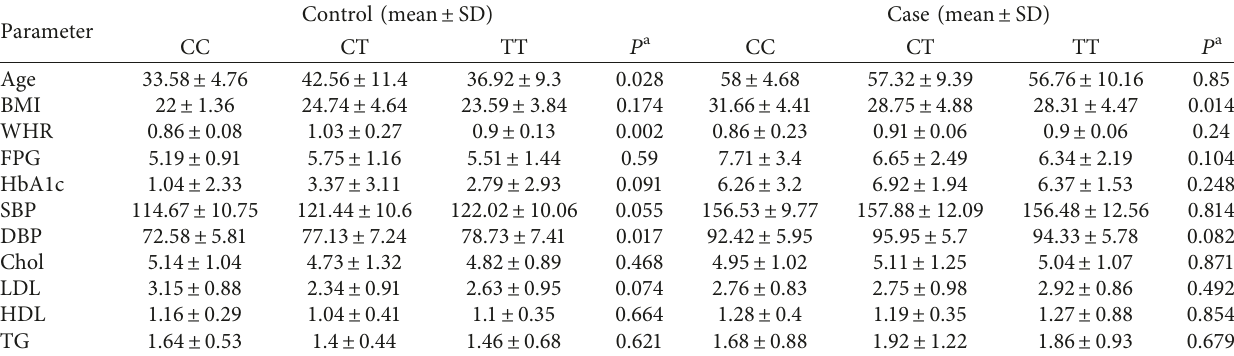
Table 5: Clinical and biochemical characteristics according to genotypes of ECE rs212526 gene polymorphism. Control (mean ± SD) Case (mean ± SD) Parameter CC CT